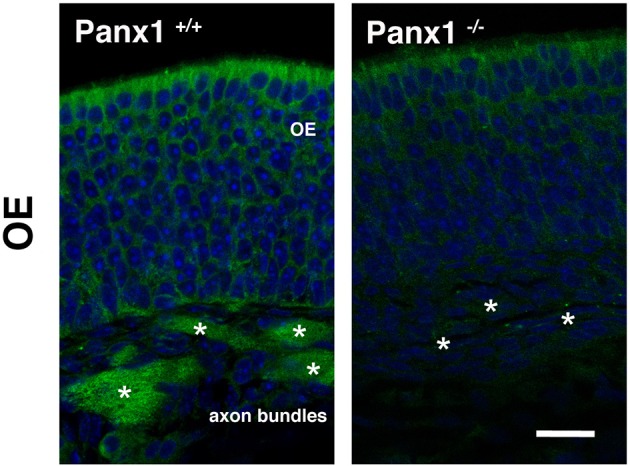
Immunohistochemical detection of Panx1 in the OE. IHC of histological section deriving from OE of adult Panx1+/+ and Panx−/− mice. In the OE, a prominent Panx1 staining (in green) was identified in OE axon bundles (asterisks), which was not detected in Panx1−/− mice. Nuclei were stained with DAPI (in blue). Images were recorded using identical conditions. Scale bars = 200 μm